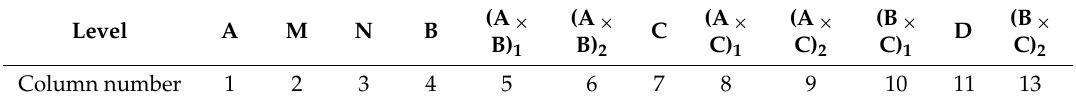
Table 9. The head of the orthogonal test considering the